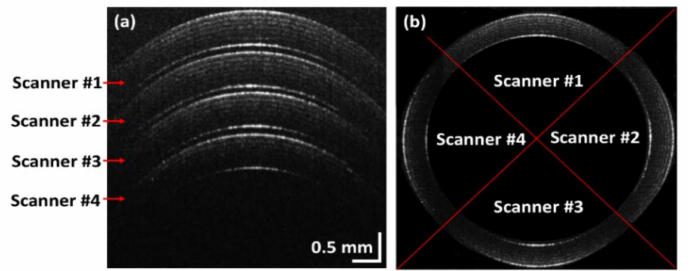
Figure 6. Simultaneously obtained images of a Scotch tape roll with the space-division multiplexing technique applied using a simultaneous quad-scanner (QS)-OCT. ( a ) is a representative B-scan image of the rolled Scotch tape imaged from four different directions with simultaneous QS-OCT, ( b ) is a merged image of the four QS-OCT images shown in ( a